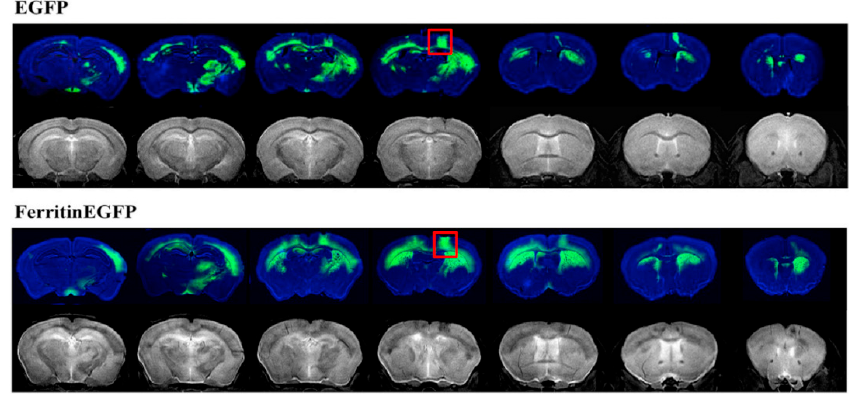
Figure 3. Brain MRI (lower in both groups) and fluorescence images (upper). Four days after rVSV- EGFP or rVSV–Ferritin–EGFP was injected into the SC (red box) of mice, the mice were killed, and the images were obtained. Reproduced with permission from Ref. [32], 2019, Elsevier.